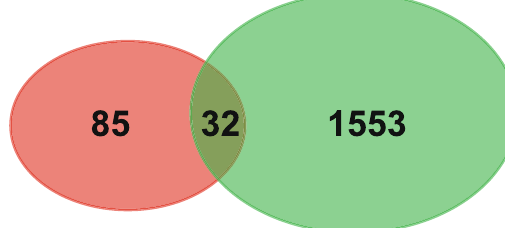
Fig. 1 | Dorsomedial hypothalamus (DMH) and lateral habenula (LHb) are the main outputs of the lateral septum (LS). a Confocal images of coronal sections showing LS A 2A R + neurons terminals in the DMH and LHb. Three weeks after injecting rAAV2/9-hSyn-DIO-EYFP into the LS of A 2A R-Cre mice, EYFP-positive axonal fi bers were found in the DMH and LHb. Scale bar: 500/200 μ m. LV, lateral ventricle; MS, medial septum. b Experimental scheme showing that CTB488 was injected into DMH or LHb of A 2A R-tag mice (to reveal A 2A R expression via anti-HA